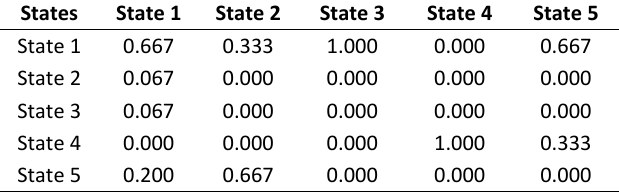
Table 5. Transition probabilities of arrested/prolonged progress group